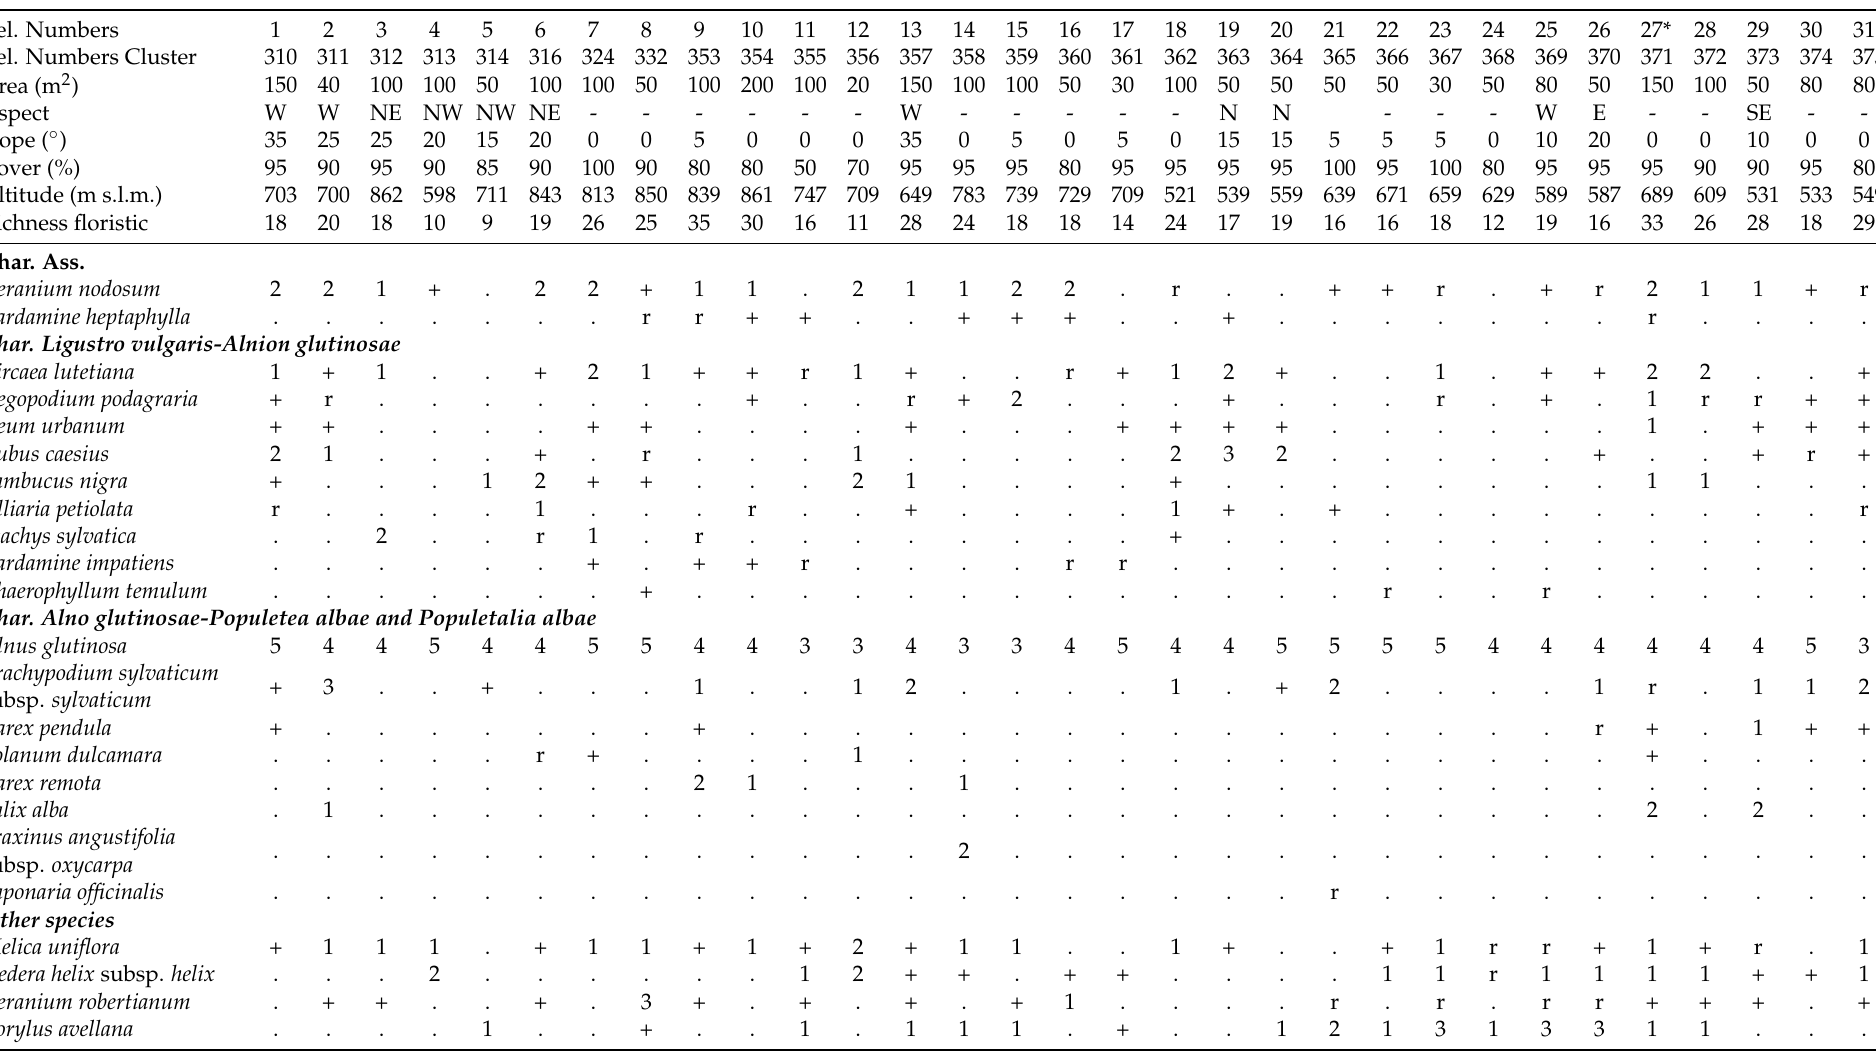
Table 2. Geranio nodosi-Alnetum glutinosae ass. nov. hoc loco. Appendix